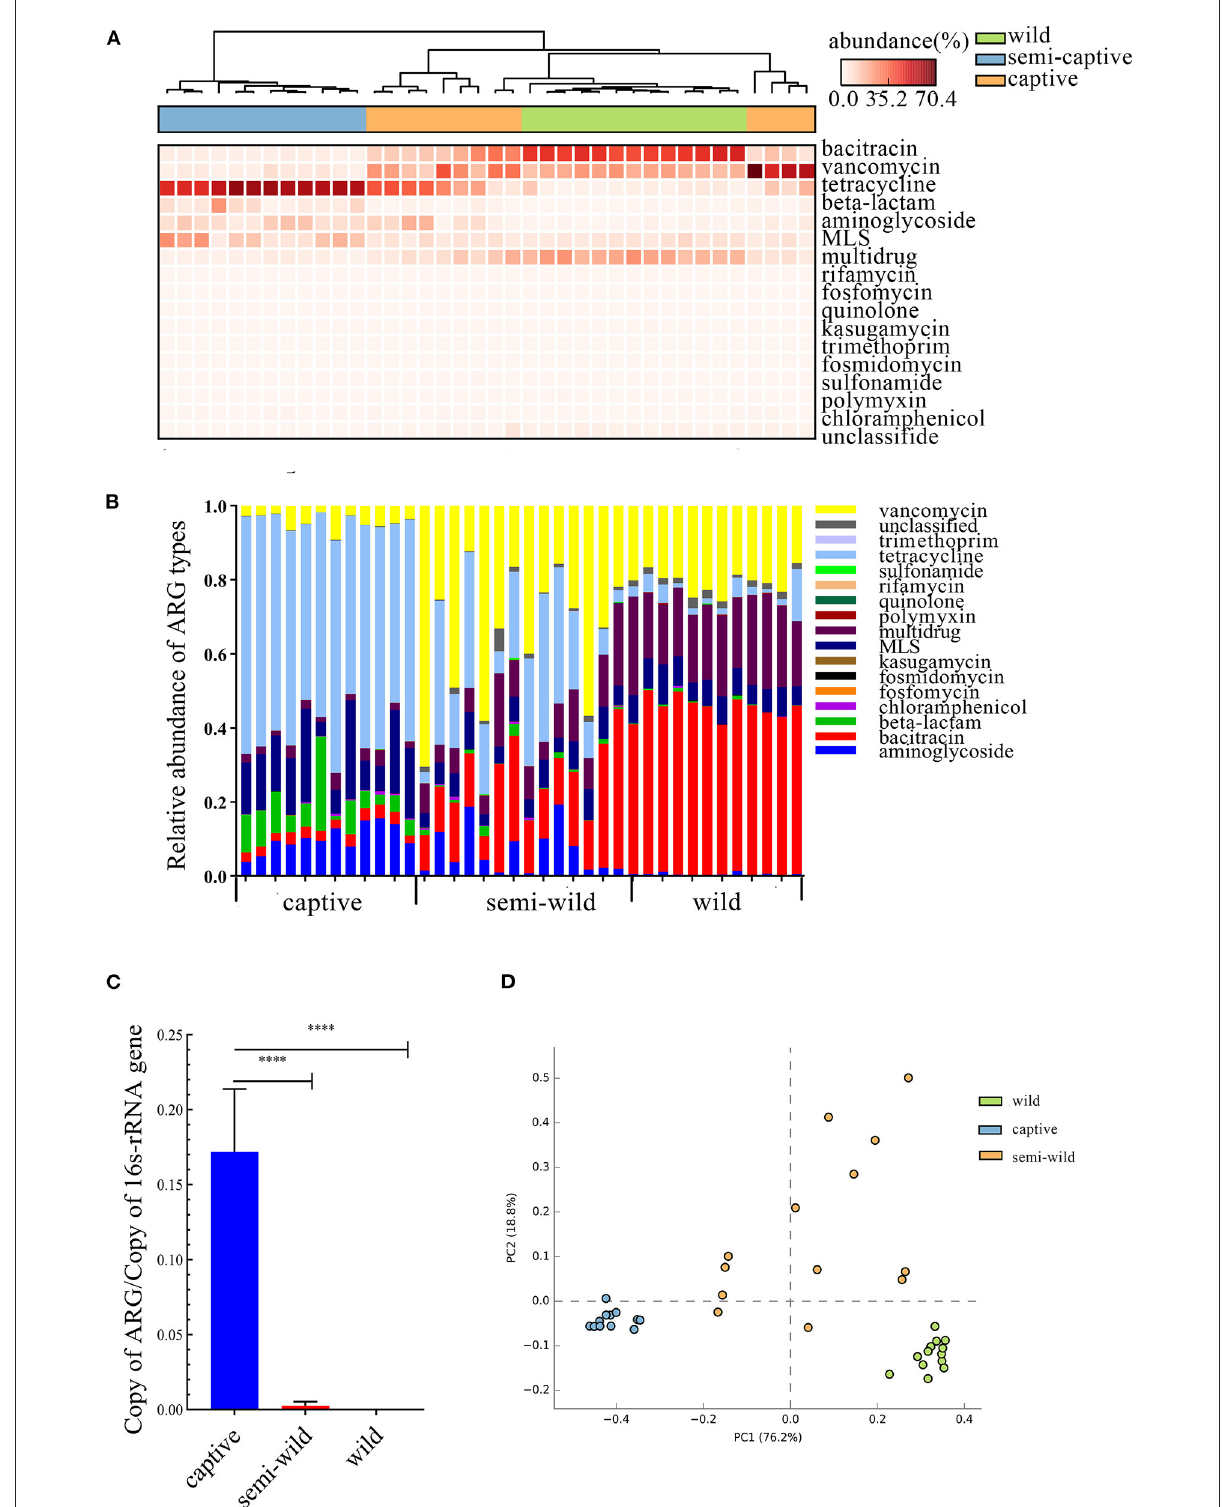
FIGURE2 Comparison of R. roxellana gut microbiota ARGs between captive, semi-wild, wild. (A) Clustering heat map of antibiotics with high relative abundance in 38 samples. (B) Relative abundance of ARG types of R. roxellana . (C) Barplot of total ARG relative abundance of 38 R. roxellana ( t -test, **** P < 0.0001). (D) PCA plot of ARG relative abundance of 38 R. roxellana